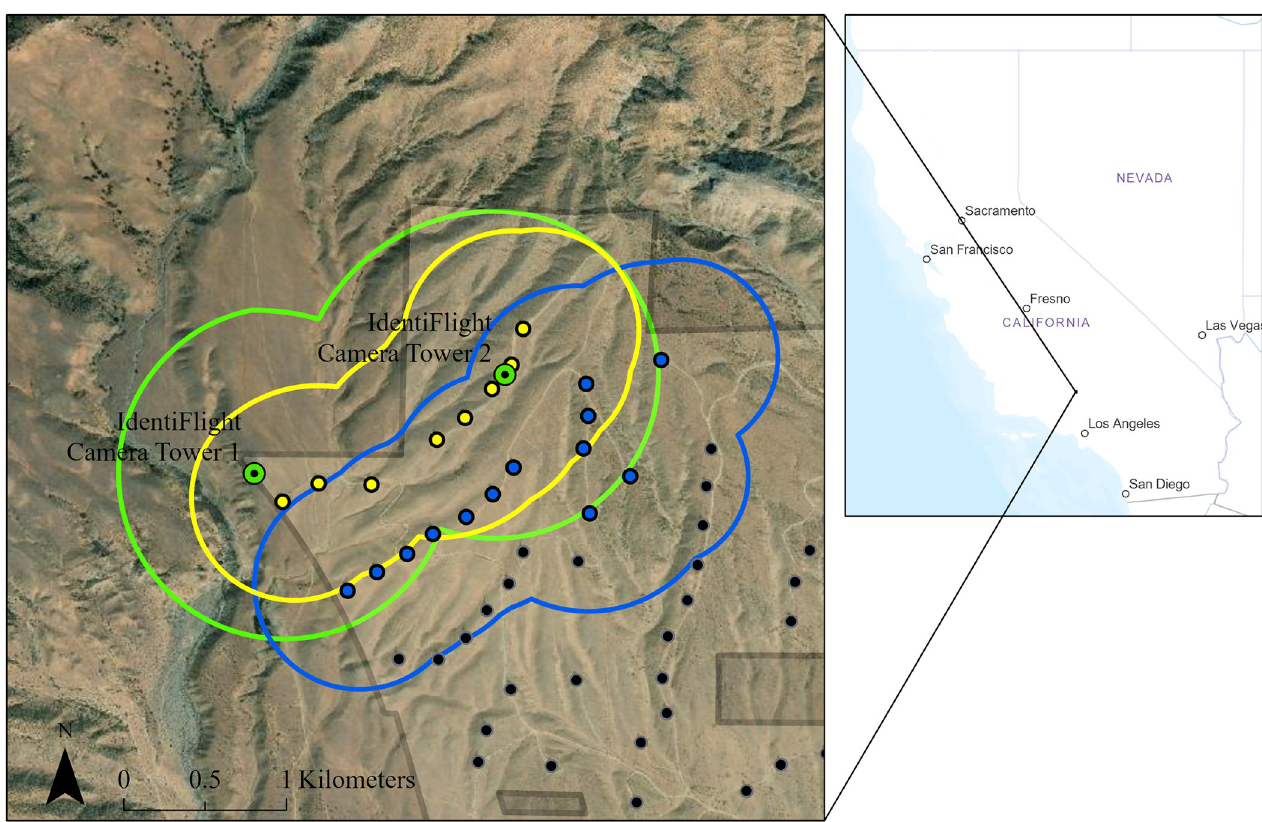
Fig 2. IdentiFlight system cameras (green dots) and turbine locations including those fully covered (yellow dots) and partially covered (blue dots) by the IdentiFlight system along the northern portion of the Manzana Wind Power Project, California, USA. Turbines were fully covered when 600 m around them (yellow line for fully covered turbines, blue line for partially covered turbines) was within 1000 m (green line) of an IdentiFlight camera.